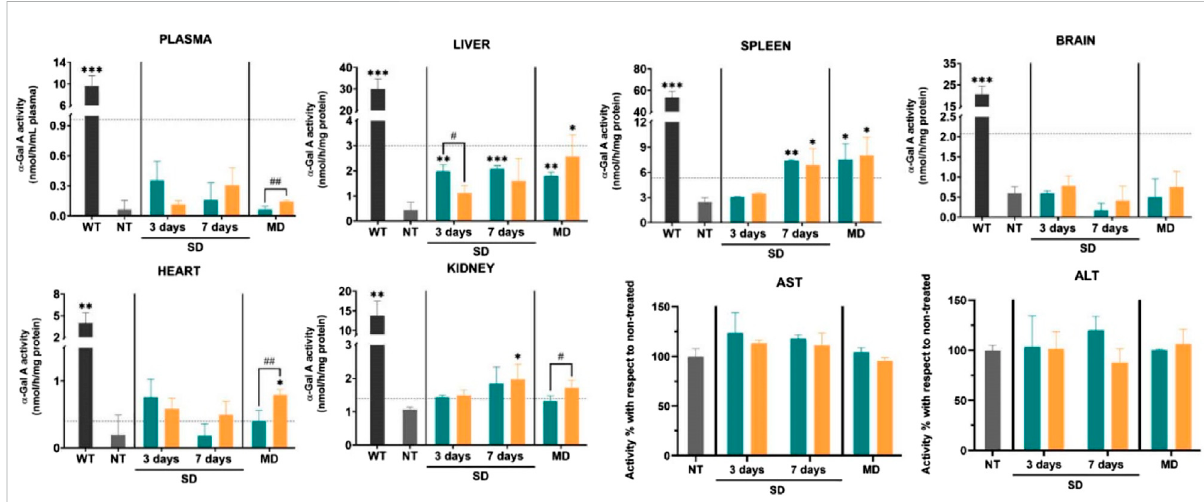
FIGURE 4 α -GLAAenzymaticactivityintheplasmaandtissues(liver,spleen,brain,heart,kidney)ofdifferentgroupsandaspartateaminotransferase(AST)/ alanine aminotransferase (ALT) activity in GLA knockout (KO) mice after various treatments. NT: non-treated; SD: single dose; MD: multiple doses; Green: plasmid DNA; orange: SLP-based vector. Reproduced with permission (Rodríguez-Castejón et al., 2021). Copyright 2021, The